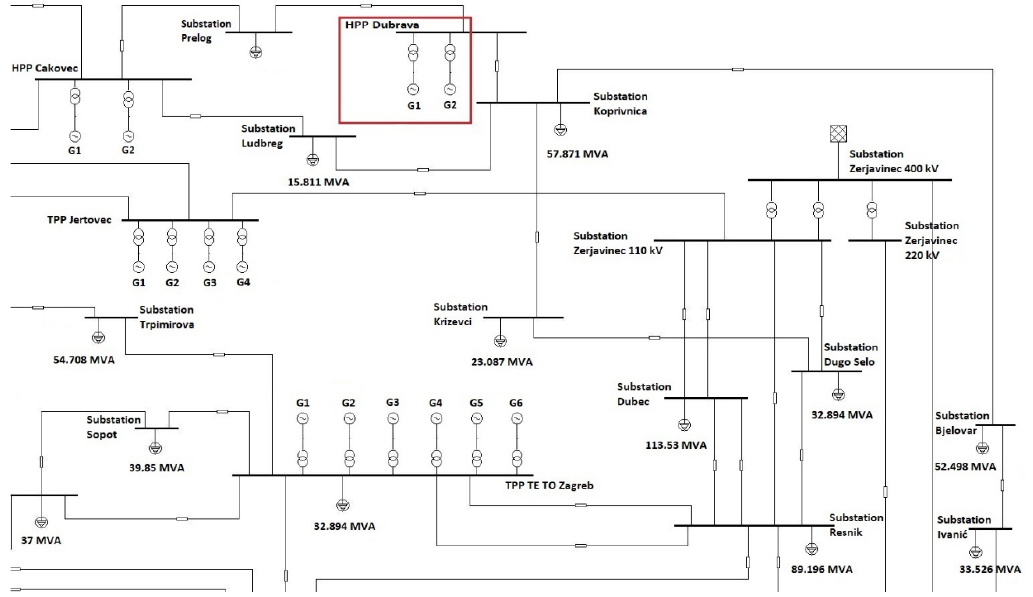
Figure 12. Illustration of a part of the Croatian power system topology used in the simulation.